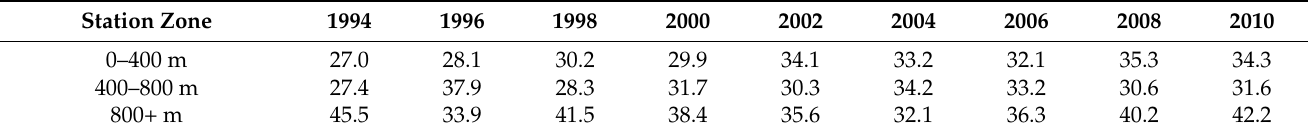
Figure 6. Amount of development areas around rail transit stations. Table 6. Annual change rate of development areas around station zones (%).